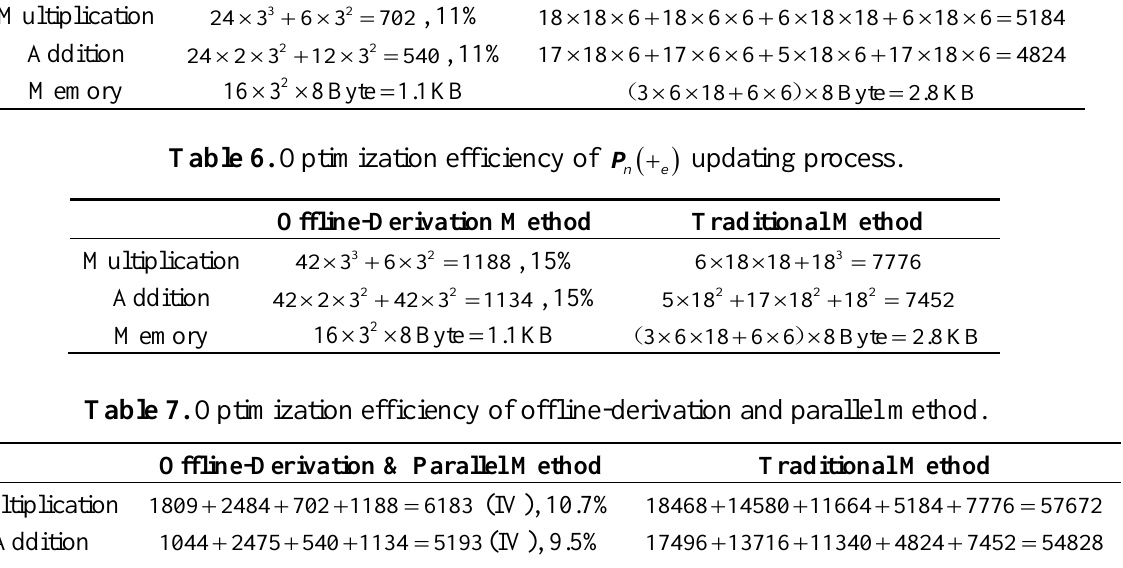
Table 5. Optimization efficiency of